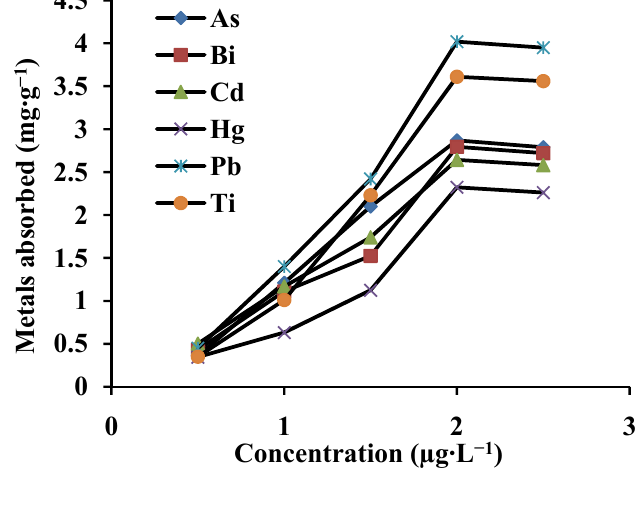
Figure 4. The breakthrough curves of the metal ions on MWCNTs at pH: 7.5; sample volume: 25 mL (N = 3).